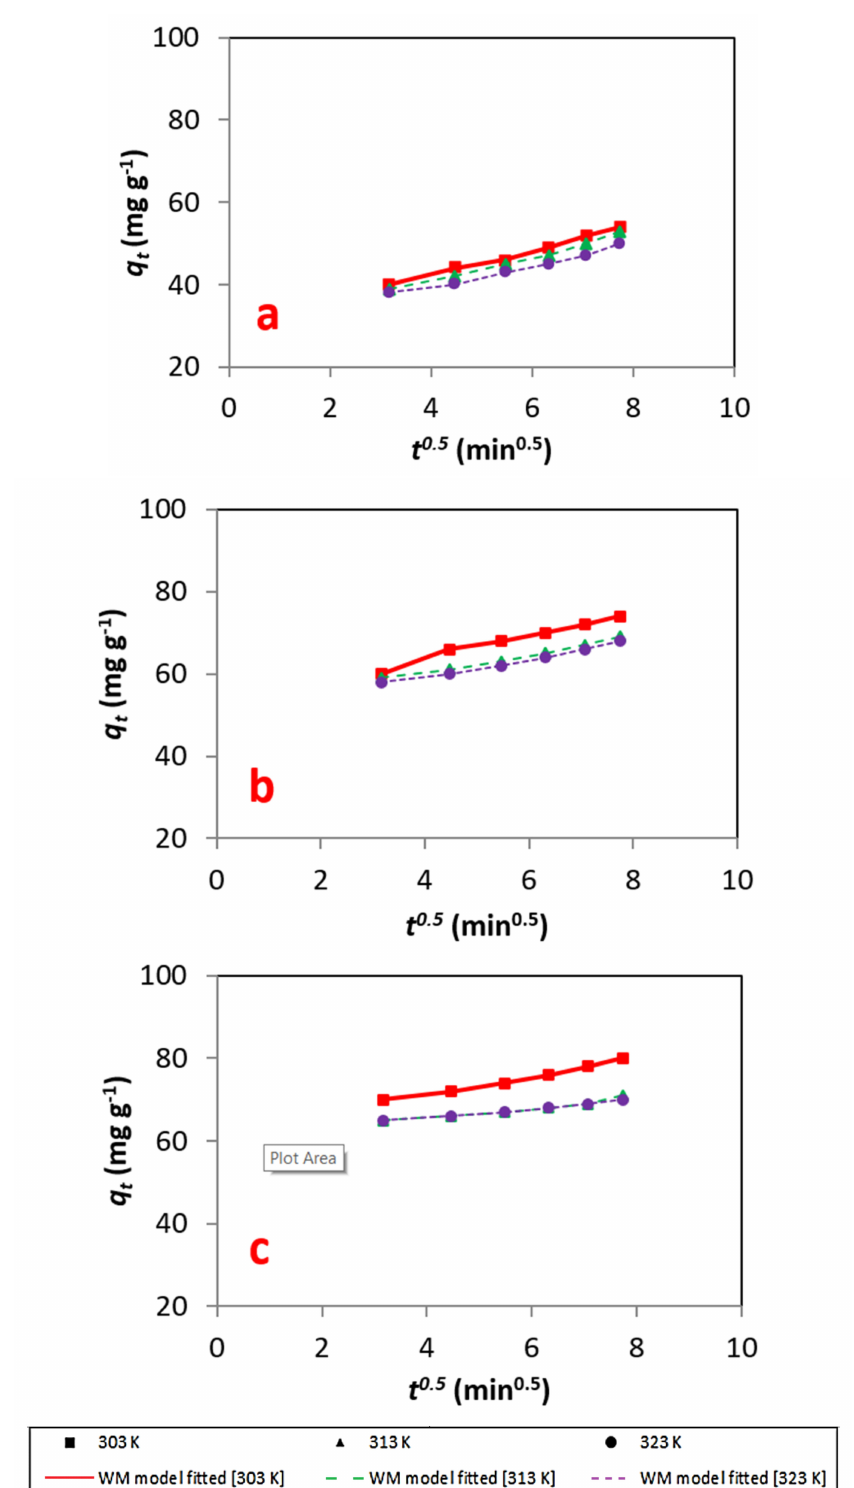
Figure 10. ( a – c ) Energy information fitted to the to the Weber–Morris model at different